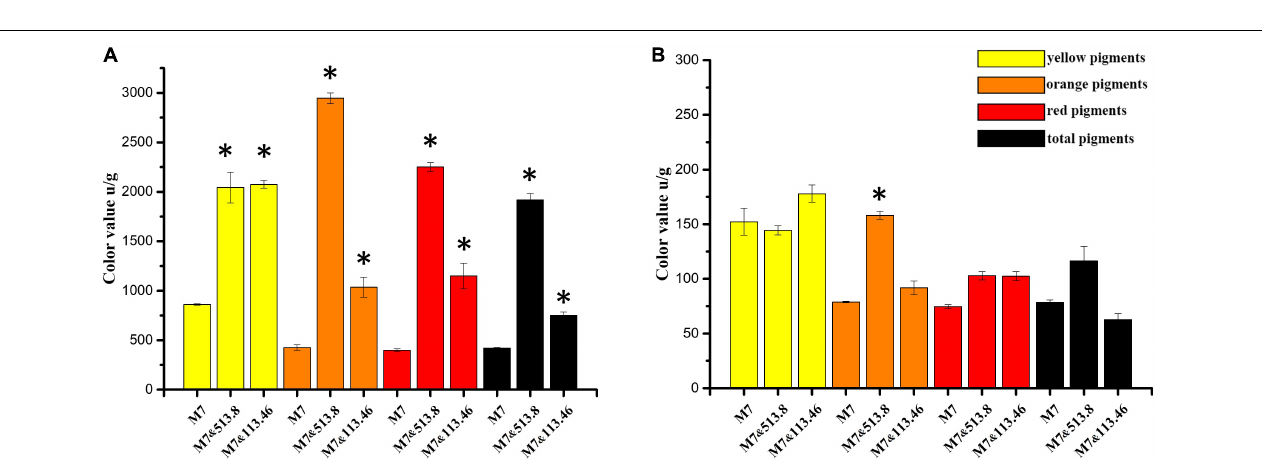
FIGURE 6 | Cocultivation micromorphologies: (A) comparison of monocultured and co-cultured (with Aspergillus niger CBS 513.88) M. ruber M7 on PDA and CYA media; (B) mycelia shape variation of M. pilosus MS-1 when co-cultured with A. niger CBS 513.88. Abbreviations: M7- M. ruber M7; M7&CBS 513.88- M. ruber M7 co-cultured with A. niger CBS 513.88; MS-1- M. pilosus MS-1; MS-1&CBS 513.88- M. pilosus MS-1 co-cultured with A. niger CBS 513.88.